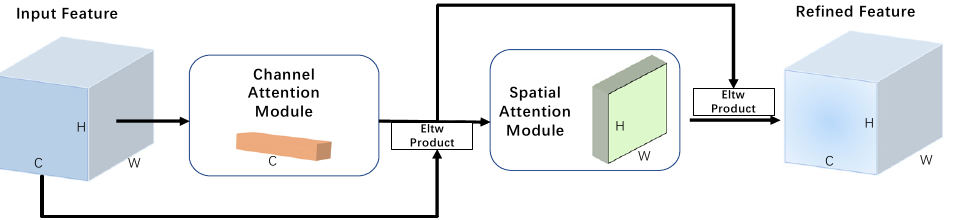
Figure 2. CBAM attention mechanism diagram. The module has two sequential sub-modules: channel attention module and spatial attention module. H is height, W is width, and C is channel. Eltw is element-wise.